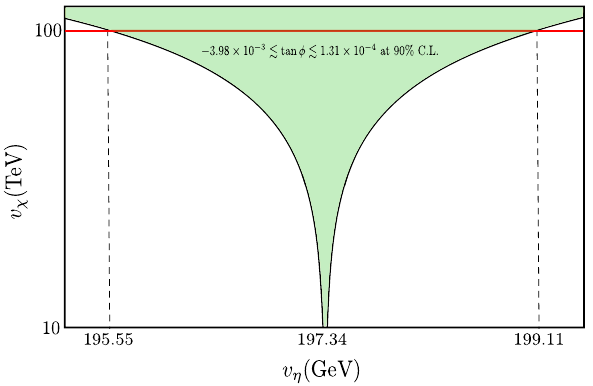
Fig. 5 Thelightgreenregioncontainsthevaluesfor v η and v χ allowing − 3 . 98 × 10 − 3 (cid:3) tan φ (cid:3) 1 . 31 × 10 − 4 . v η values at least 1% different from 197 . 34 GeV require v χ (cid:2) 100 TeV